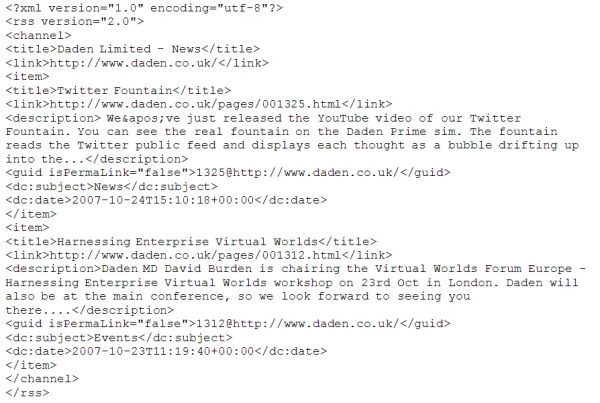
An example RSS feed.